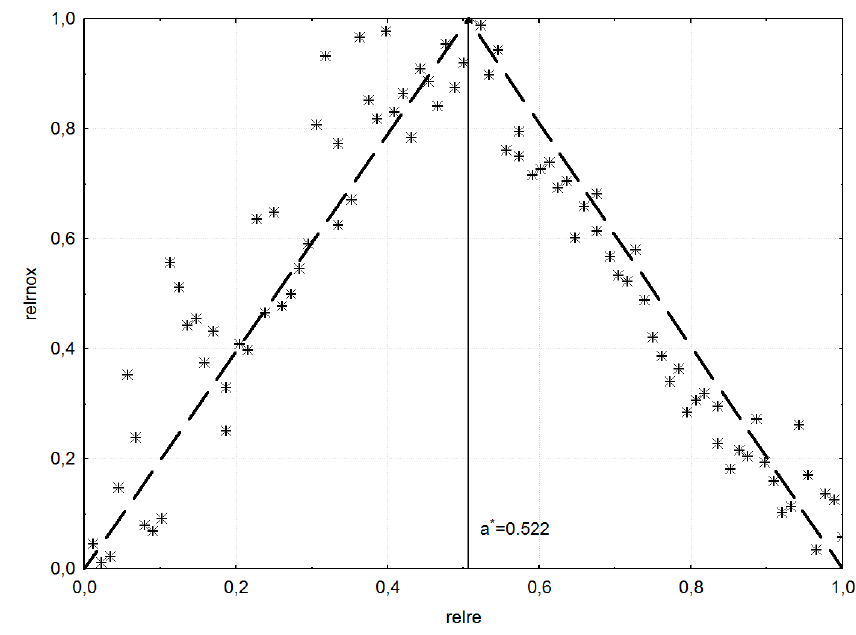
Figure 1: empirical copula of the dataset "engine". The dashed line shows the ideal line for perfect piecewise